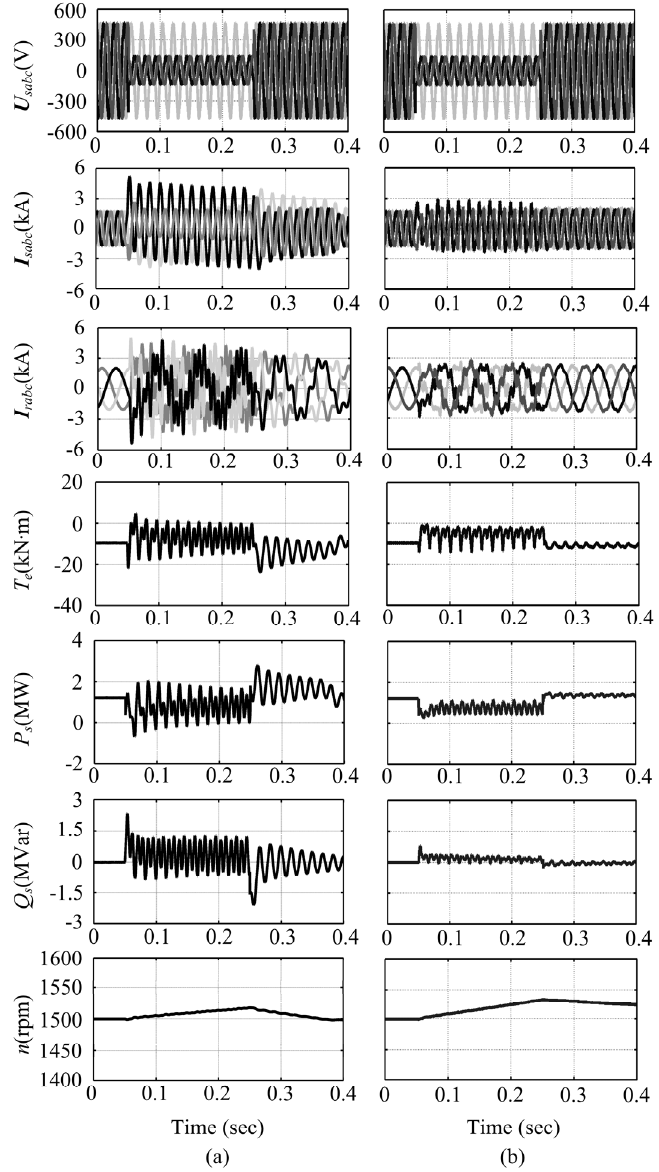
Figure 12. Simulation results on a DFIG when a 70% phase-phase-ground voltage drop occurs. ( a ) Conventional control; ( b ) Proposed